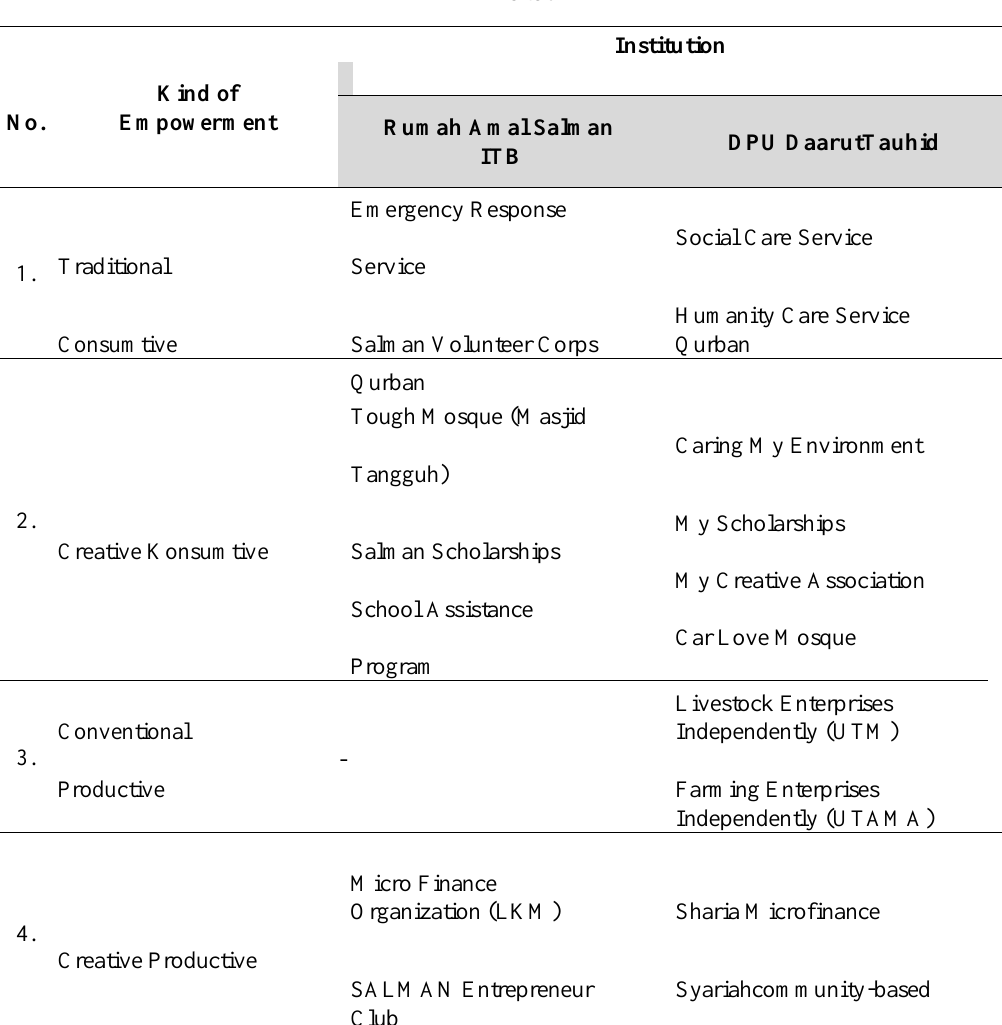
Table 3 Format of Allocation Program of Empowerment Zakat Fund in